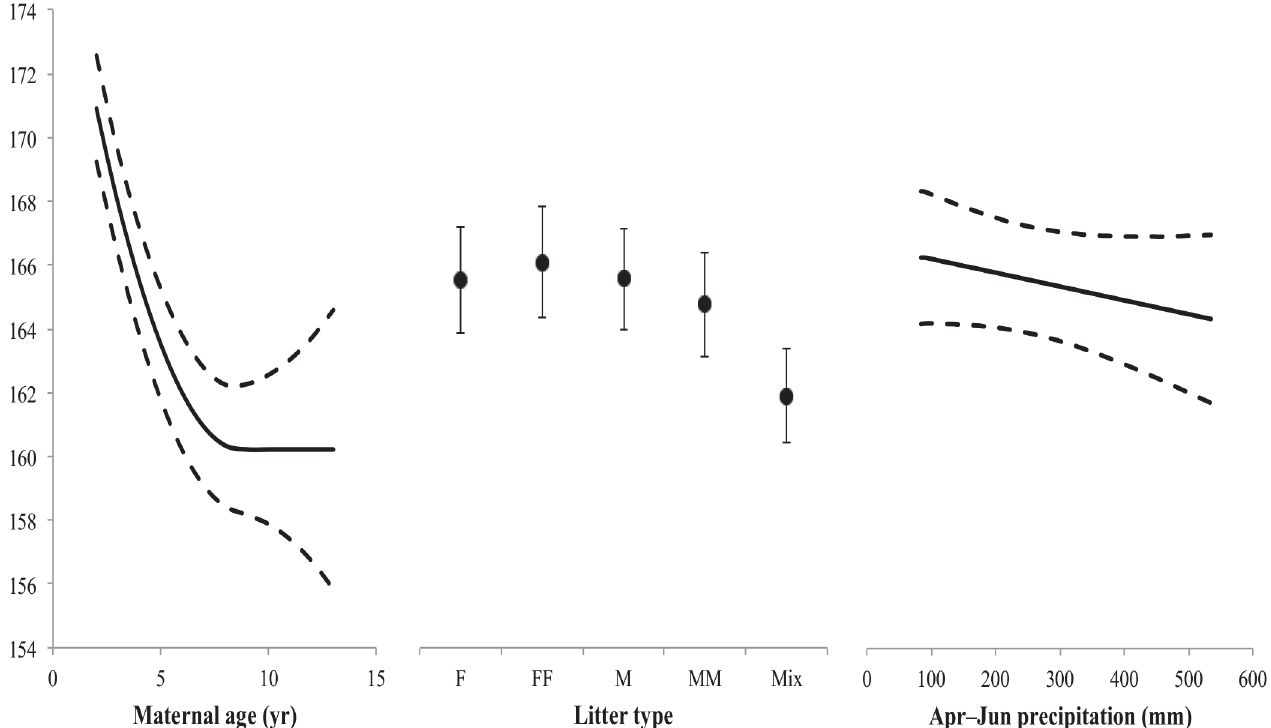
Fig 3. Predicted values from a linear mixed effect model estimating the parturition date (in Julian days) of captive white-tailed deer at Kerr Wildlife Management Area, Kerr County, Texas, USA from 1977 – 2012. Regression coefficients were obtained from model-averaged parameter estimates of competing models. Predicted Julian birth date was estimated across the range of each variable deemed important while controlling for all other variables (variable constants included: Maternal age = 4, Litter type = female singleton, Study program = study program 1, April – June precipitation = 256.2 mm, October – Jun precipitation = 611.7 mm, June precipitation = 102.6 mm, and November temperature = 20.4°C). The solid lines represent the predicted estimate for Julian birth date and the dashed lines are the standard error envelopes for the estimates. Random effects were treated as categorical variables and included a unique identifier for each mother and the year of birth for each fawn.